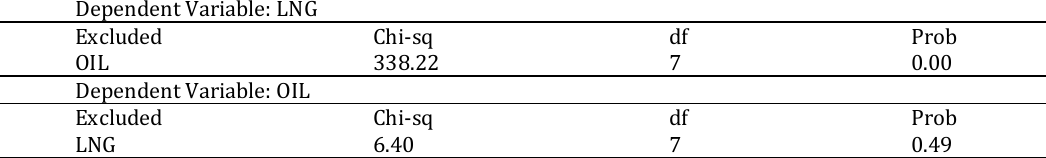
Table 1: Causality test